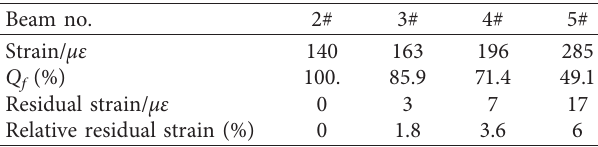
Table 7: Strain result of tensile side (measuring points 4–6#) under normal loading. Beam